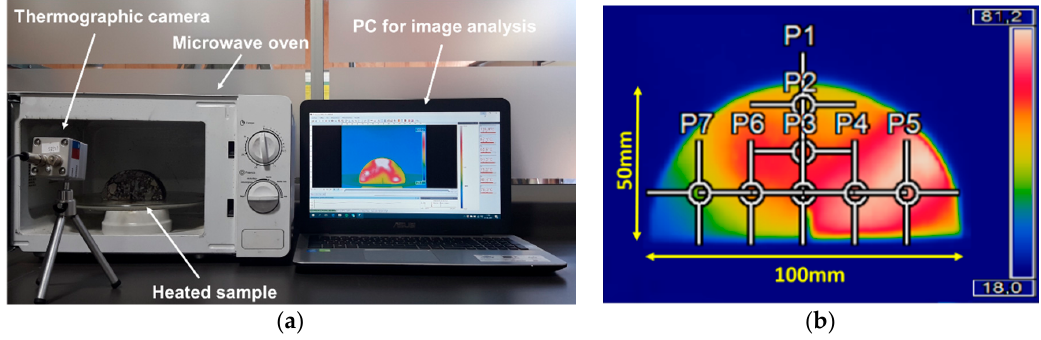
Figure 1. ( a ) Microwave heating test; and ( b ) surface temperature measurement points, example for an asphalt mixture with 4% of fibres heated during 30 s.